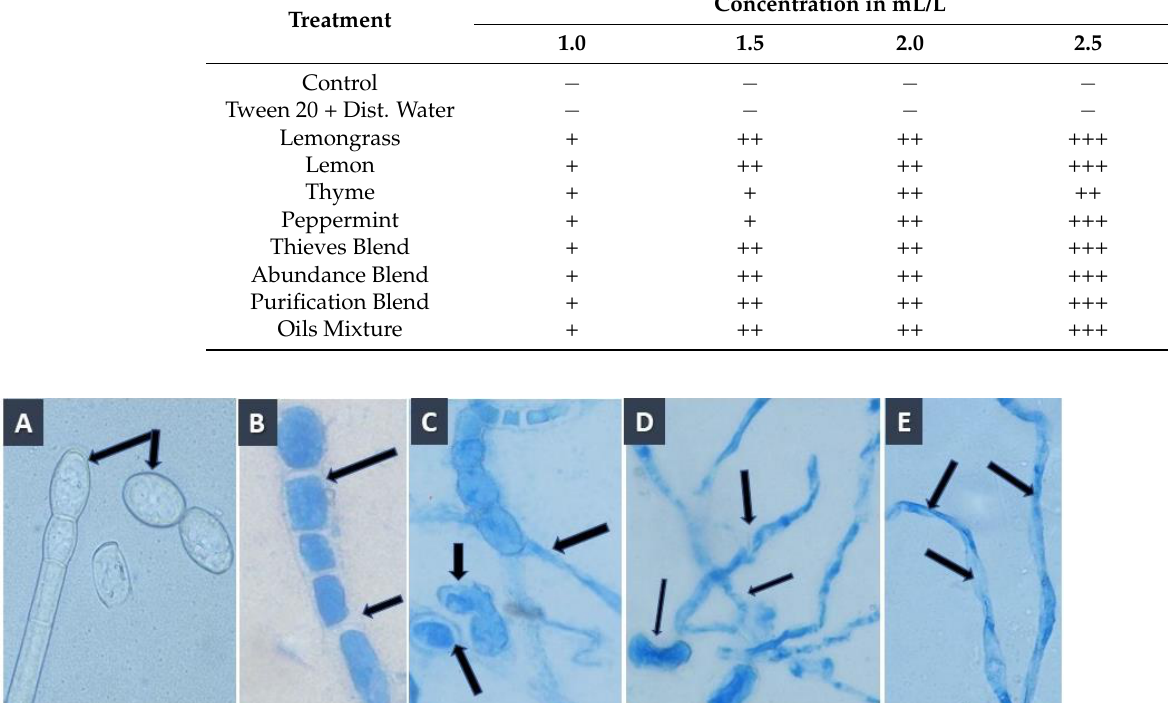
Figure 1. Fungitoxic effects of the essential-oil mixture on the structure of the mycelia and conidia of Podosphaera xanthii . Healthy and well-developed conidia in their definite shape in the control ( A ); mycelia and conidiophores showing some deformation, in which the protoplasm is shrinking away from the cell wall ( B ); strong malformations in the mycelia and conidia ( C ); very strong plasmolysis in the mycelia and conidia ( D ); and completely dead mycelia ( E ).